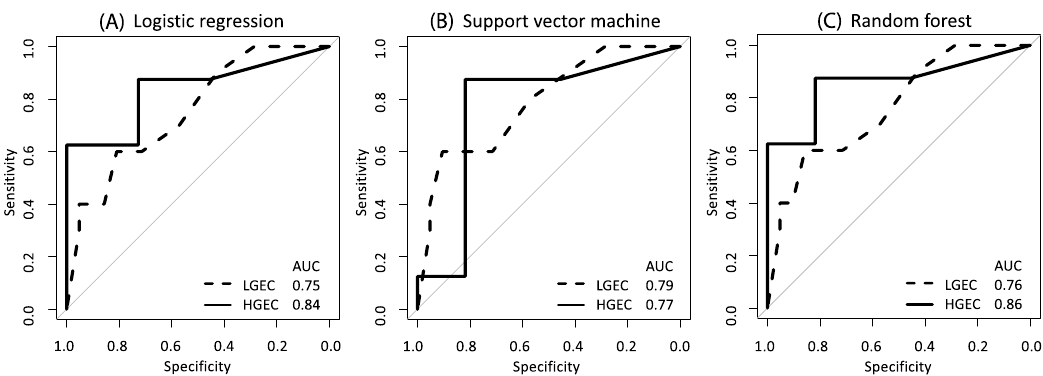
Figure 2. Predictive performance of lymph node metastasis by biopsy histological types (low-grade endometrial cancer / high-grade endometrial cancer (training set: National Cancer Center Hospital (NCCH) training set ( n = 75), test set: NCCH test set ( n = 50) and Showa University Hospital (SUH) set ( n = 129). ( A ) Receiver operating characteristic (ROC) curves using logistic regression. ( B ) ROC curves using support vector machine. ( C ) ROC curves using random forest. Solid and dashed lines show the HGEC and the LGEC test sets, respectively. AUC The area under the ROC curve, HGEC High-grade endometrial cancer, LGEC Low-grade endometrial